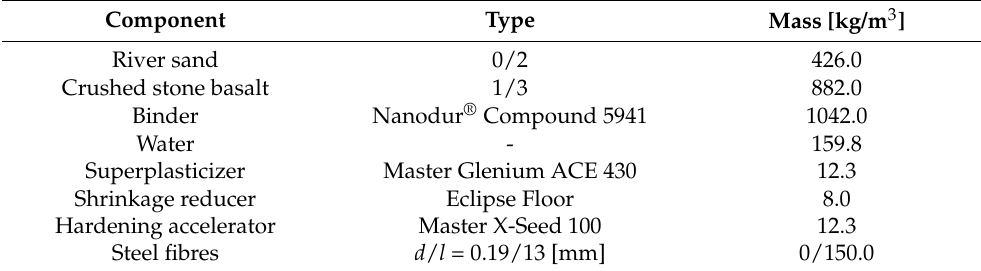
Table 1. Concrete mix of high-performance